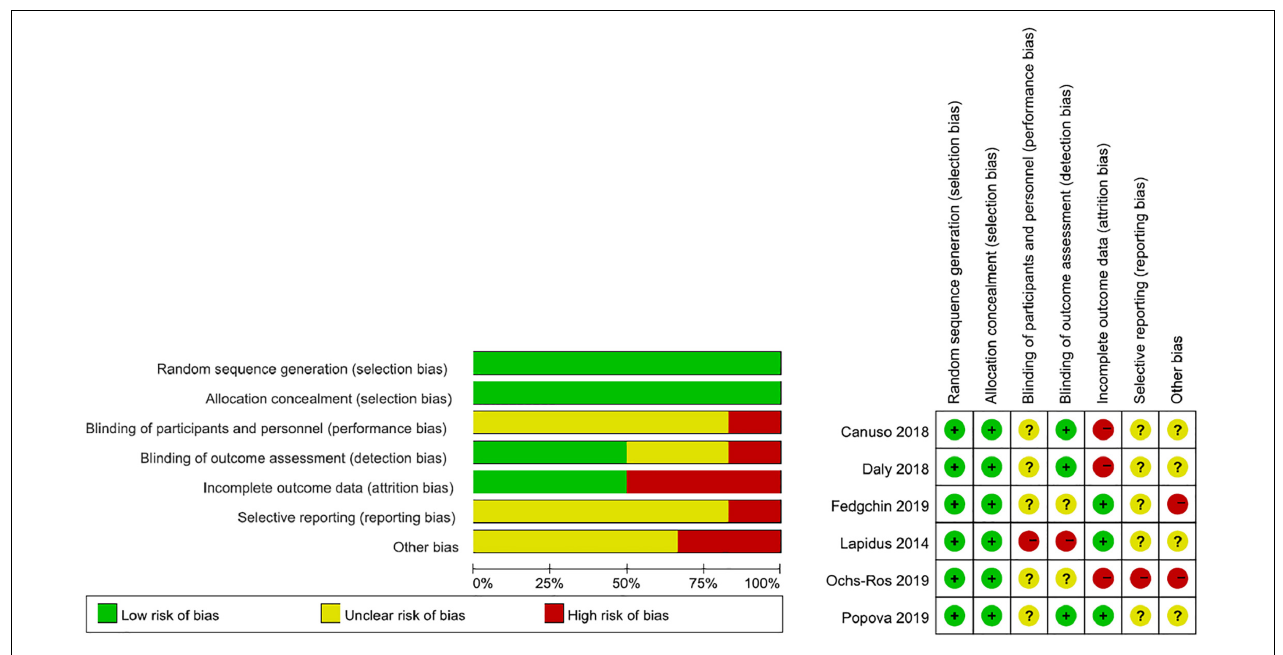
FIGURE 2 | Potential sources of bias in included trials.